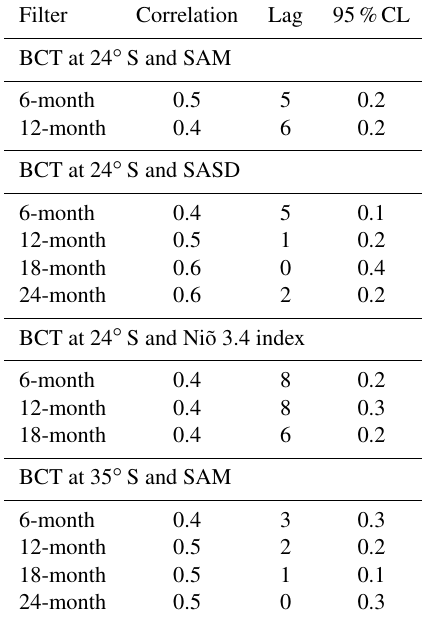
Table 4. Correlations between various indices and the transport of the Brazil Current (BCT). Time series of the Brazil Current and the indices for the 12 month filter are shown in Fig. 9. SASD – South Atlantic Subtropical Dipole Mode; Sam – Southern Annular Mode. Only significant correlations are shown. CL – confidence